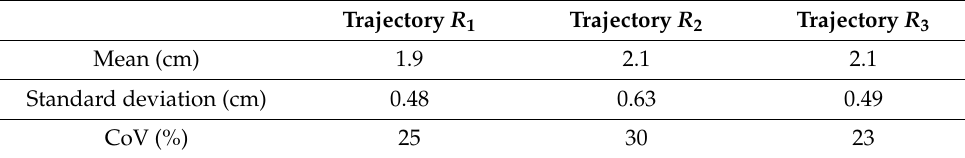
Table 5. Statistics for the roughness of the three trajectories.